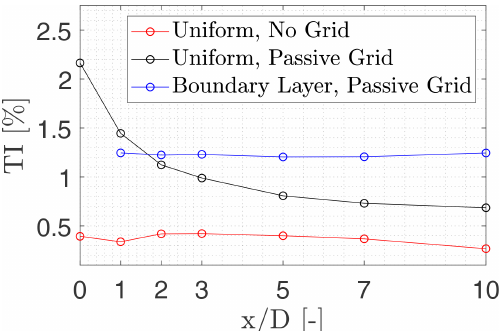
Figure 3. Turbulence intensity for each inflow condition within the wind tunnel segments at each downstream distance at hub height conducted with the staring mode measurements. Note that x/D = 0 in the turbine coordinate system is 2.4 D downstream of the in-